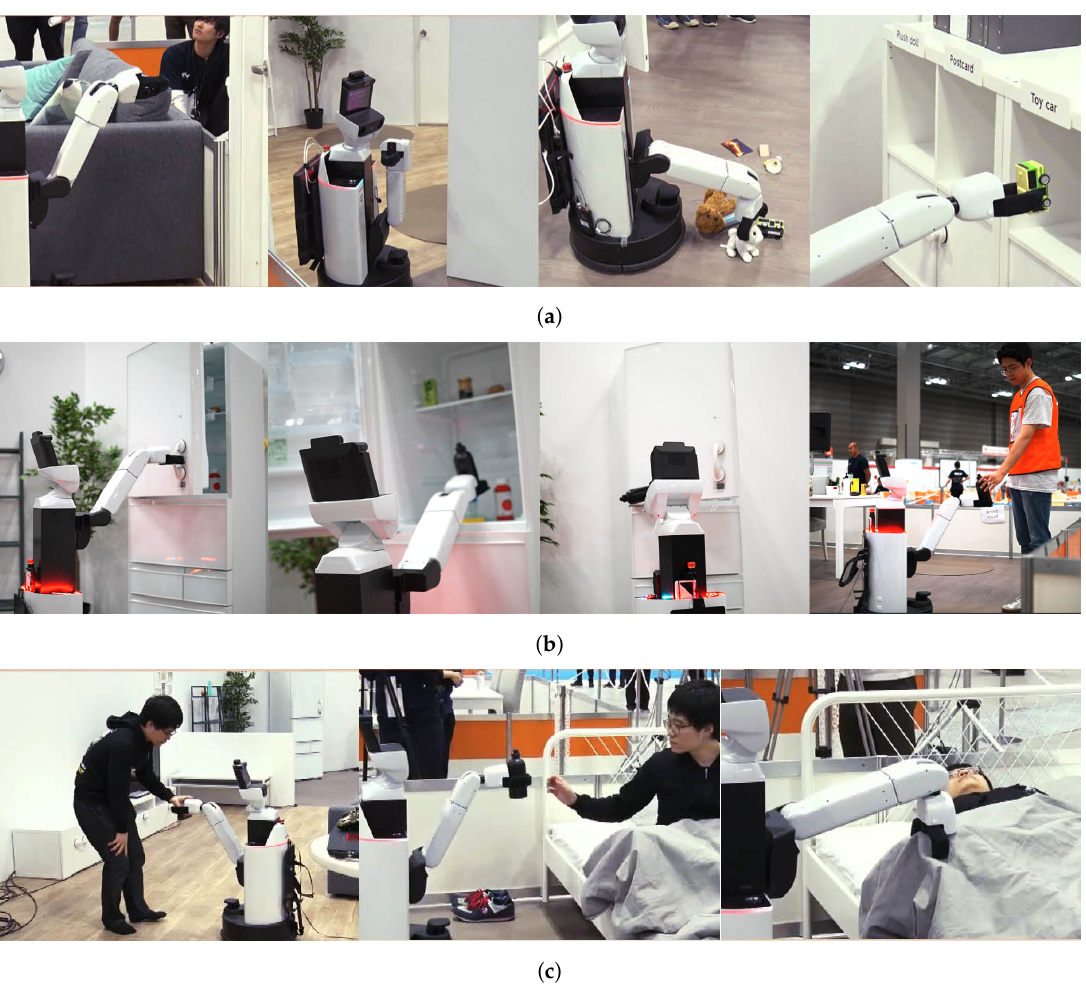
Figure 14. The HSR doing various tasks at the WRS 2018 Competition. ( a ) Tidy Up Here Task, ( b ) Bring Me Task and ( c ) Show Me the Future